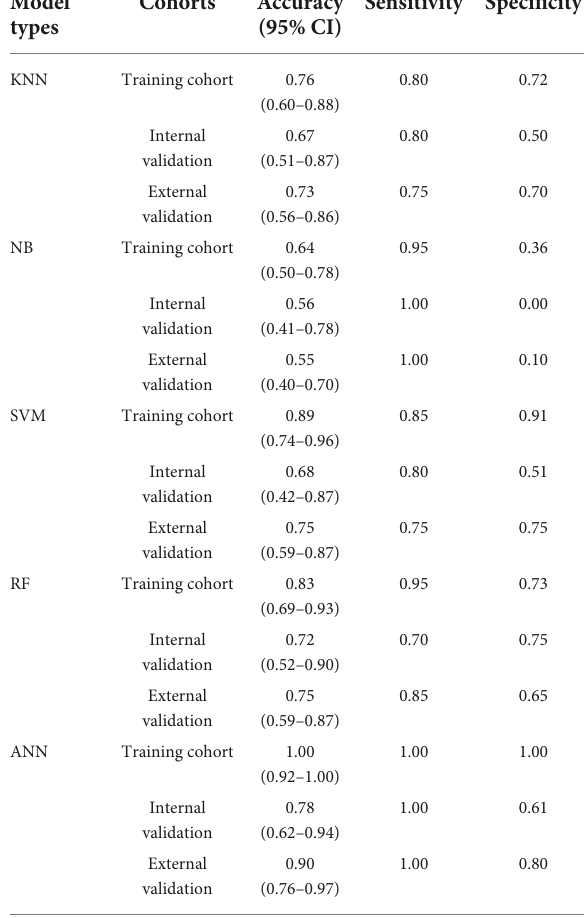
TABLE 1 Accuracy, sensitivity, and specificity of each machine learning model. Model